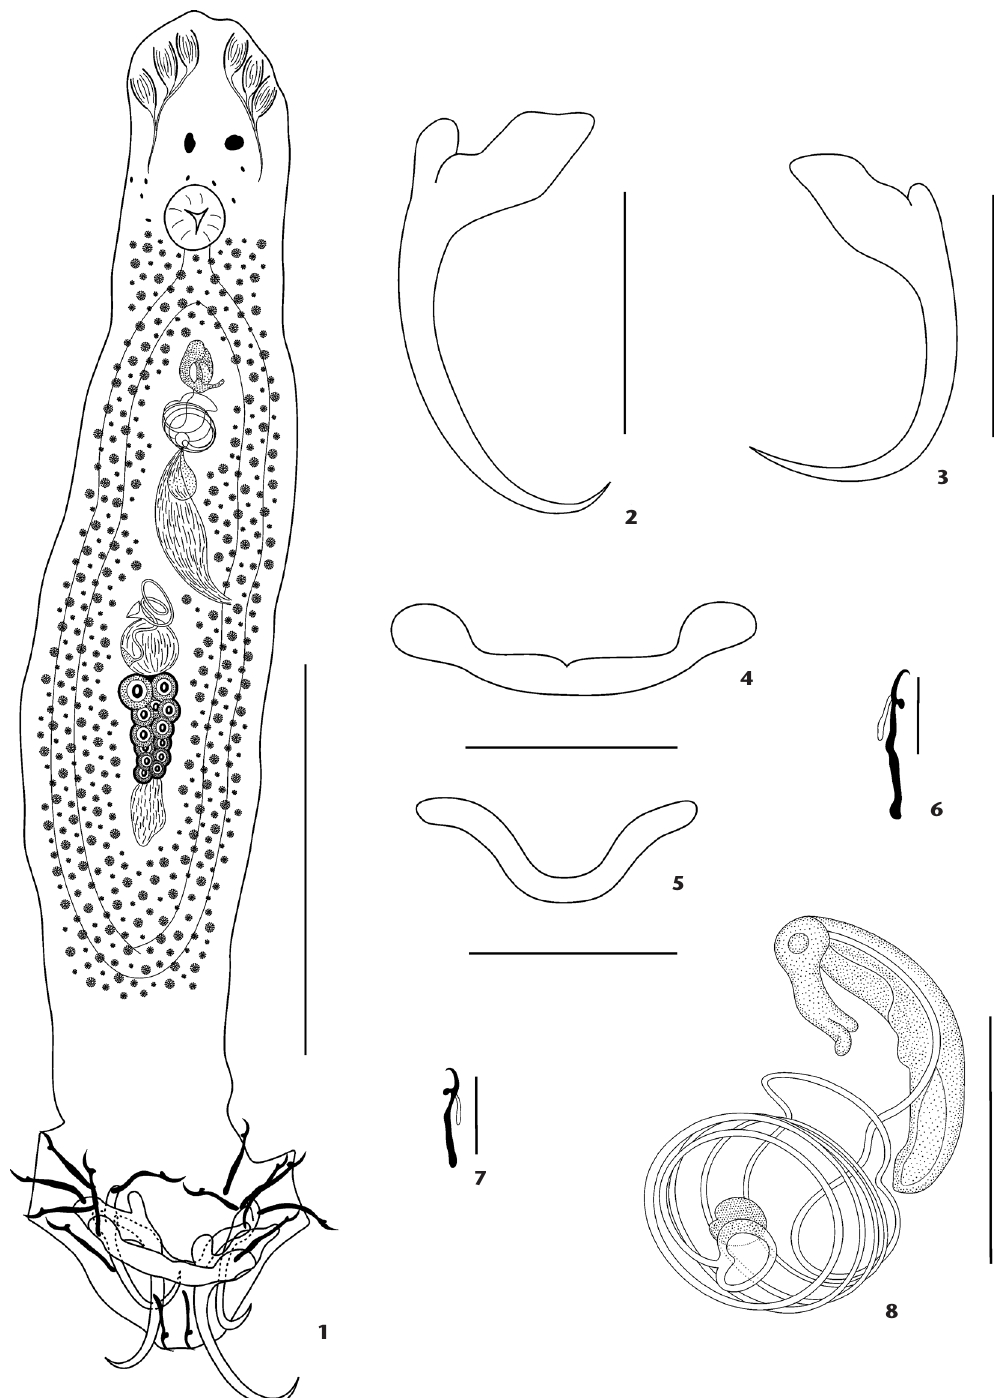
6Figures ventral bar; (5) dorsal bar; (6) hook (pair 2); (7) hook, pair 5; (8) copulatory complex (dorsal). Scale bars: 1 = 100 µm, 2-5 = 25 µm, 6-7 = 10 µm, 8 = 20